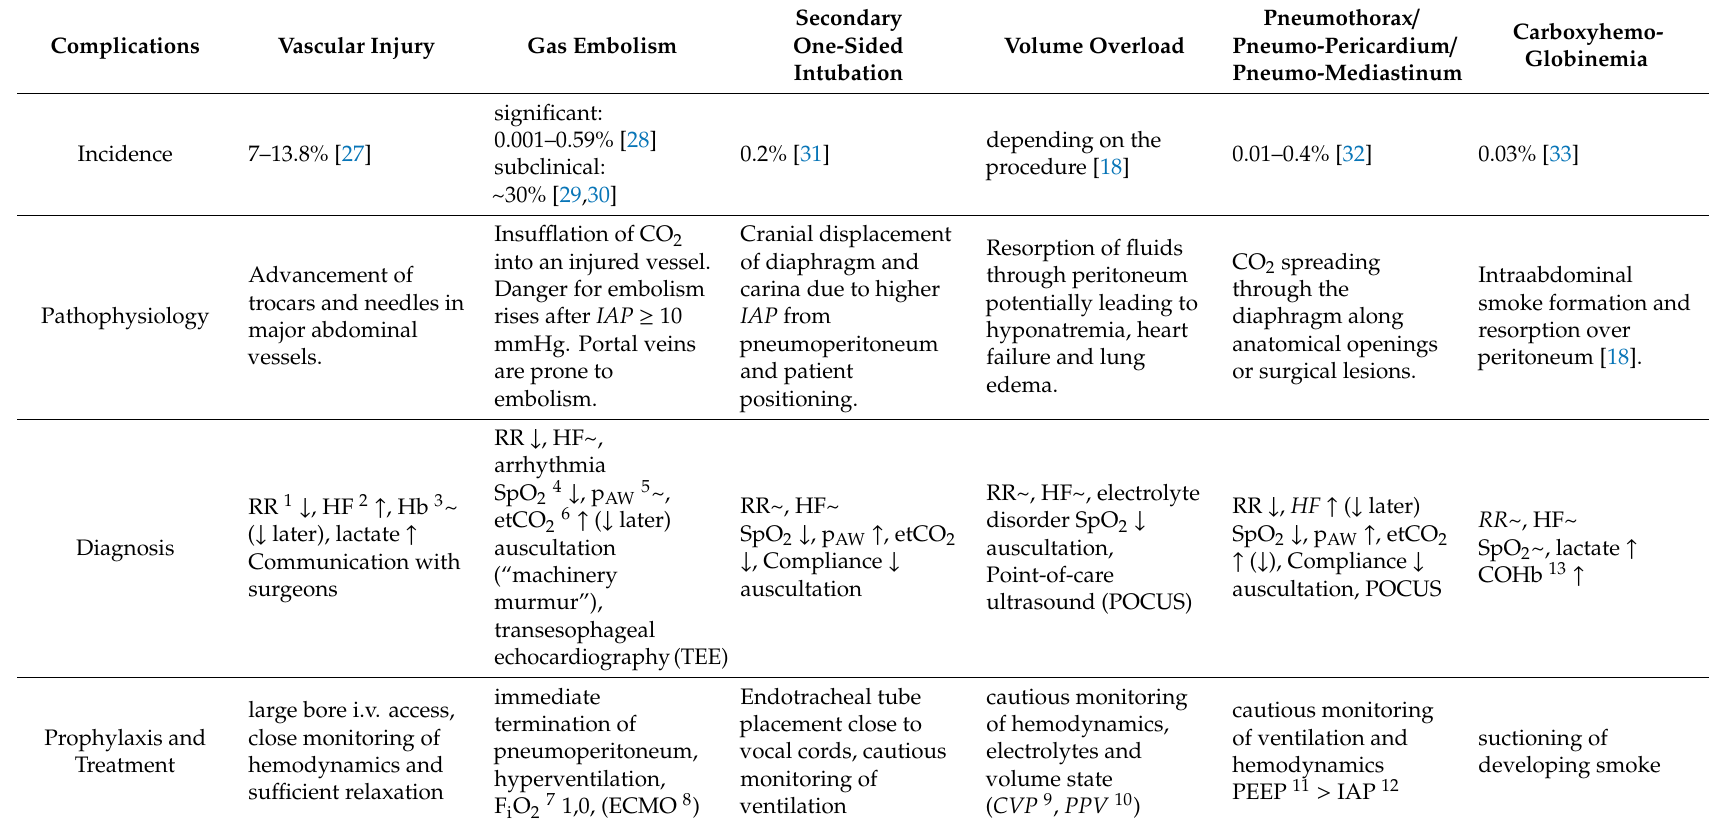
Table 2. Intraoperative complications of laparoscopic and robotic